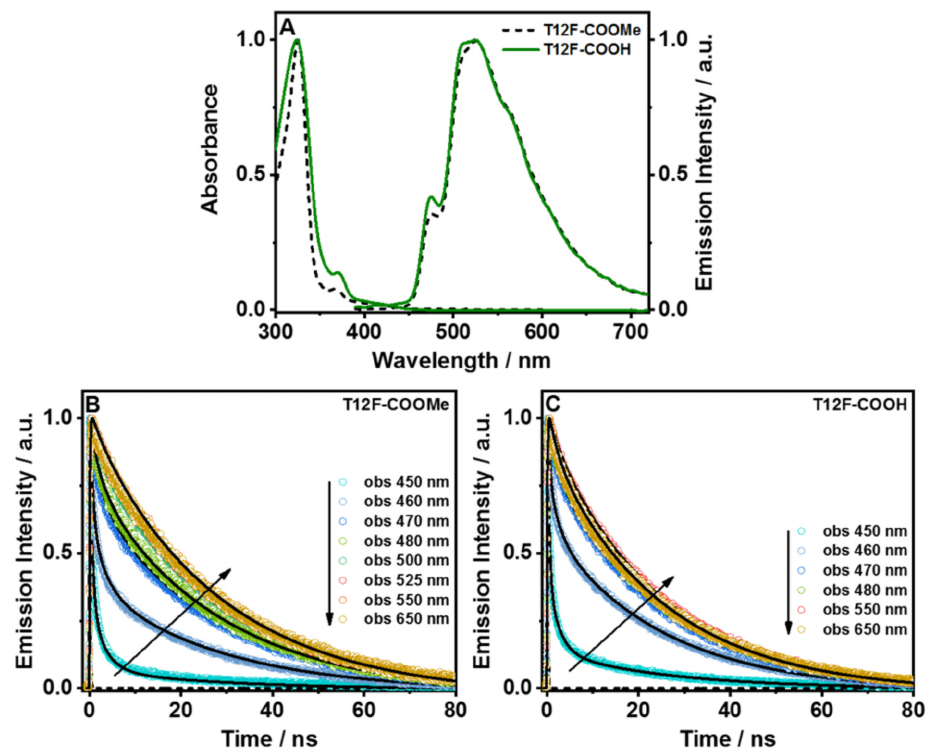
Figure 3. ( A ) Steady-state absorption and emission spectra of T12F-COOMe and T12F-COOH in DMF solution. The excitation wavelength was 370 nm. Magic-angle emission decays of ( B ) T12F-COOMe and ( C ) T12F-COOH in DMF solution upon excitation at 390 nm. The solid lines are from the best global fit using a multiexponential